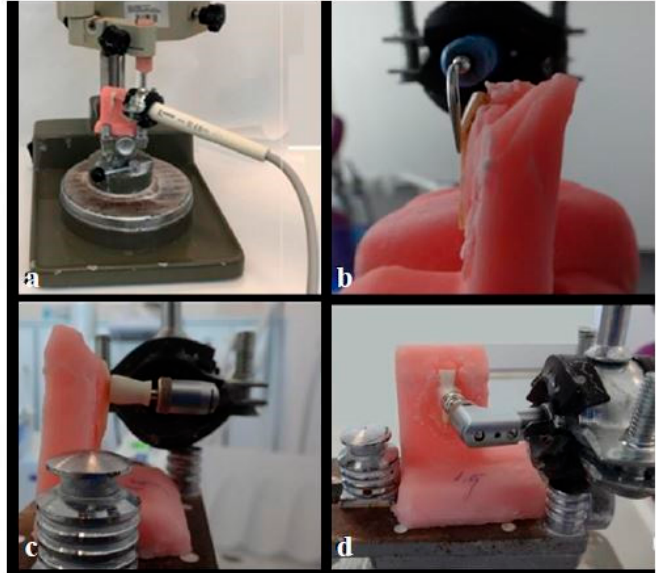
Figure 2. Handpieces fixed to the setup ( a ) Piezoelectric ultrasonic scaler, ( b ) Magnetostrictive ultrasonic scaler, ( c ) Rubber prophy cup, ( d ) Nylon bristle brush.